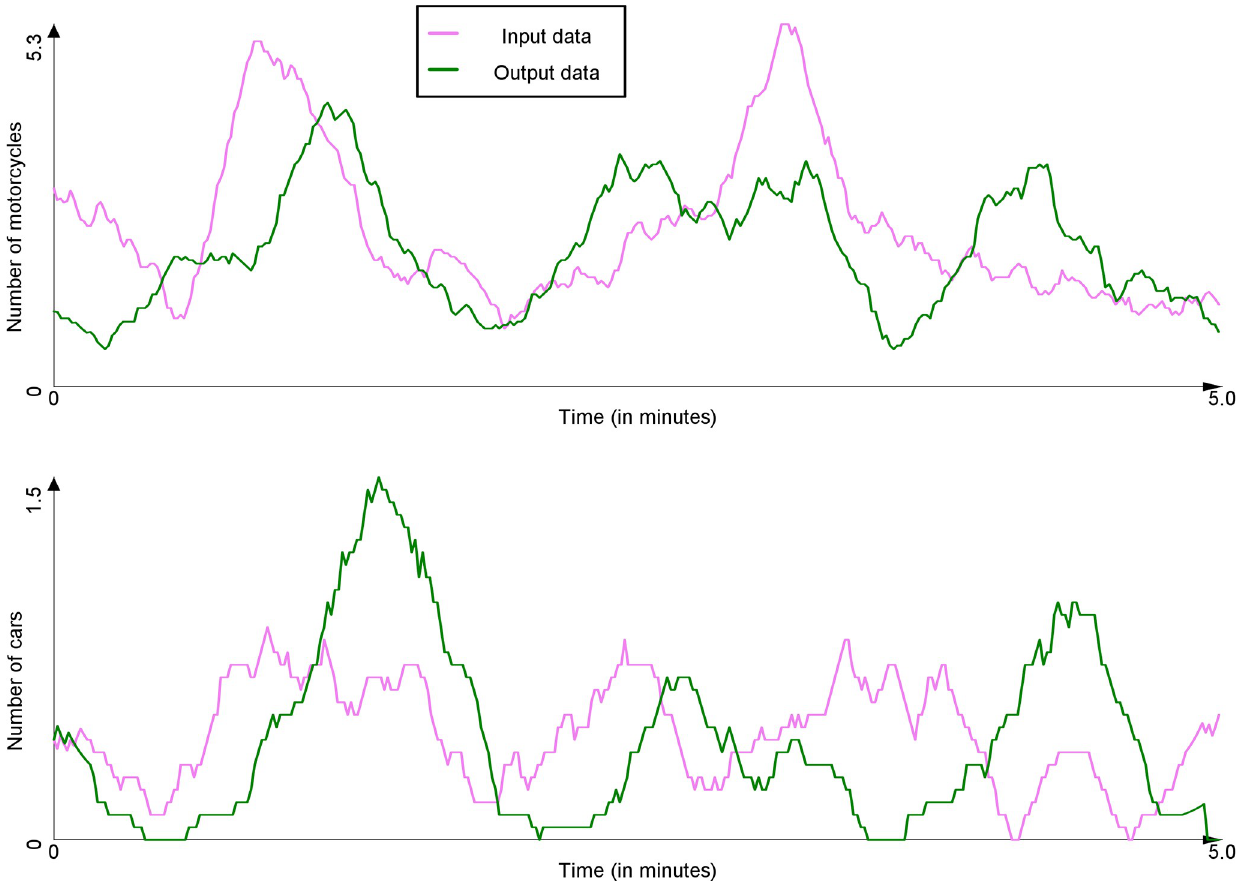
Fig 6. Count of vehicles at the input and output points for the Tay Son site (time series were smoothed out using moving average with a window size of